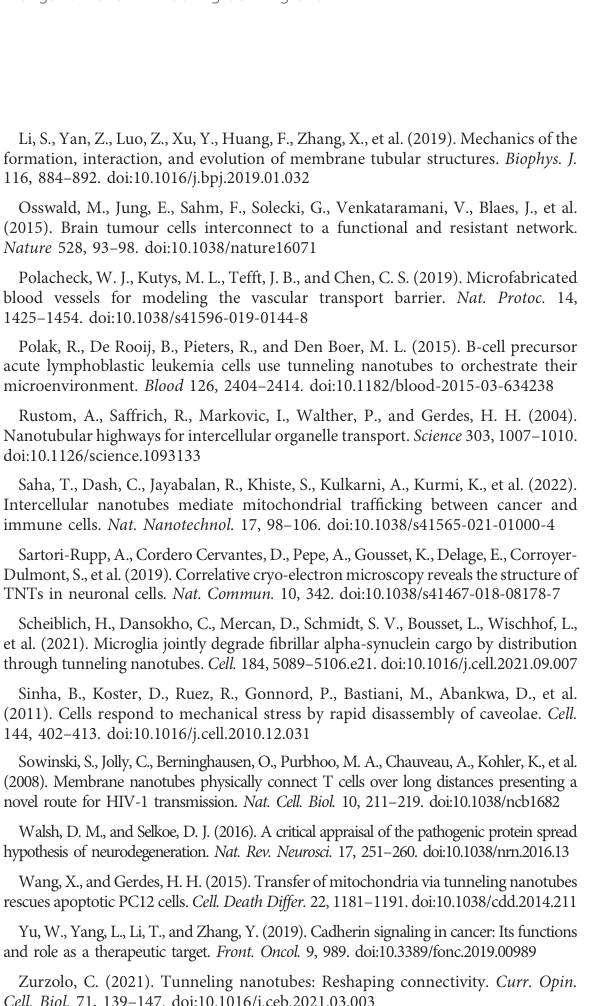
SUPPLEMENTARY FIGURE S2 TNT breaks during cell migration.A TNT (arrow) broke (00:10) when the distance between the TNT-connected cell pair increased due to cell migration. Scale bar, 20 μ m. SUPPLEMENTARY FIGURE S3 Cytoskeletal composition of TNTs and cadherin expression in HEK293 cells. (A) TNTs (arrows) did not contain microtubules (top) and vimentin (bottom). (B) HEK293 cells expressed N-cadherin but not E-cadherin at cellular junctions (arrowheads). Scale bars, 20 μ m. SUPPLEMENTARY FIGURE S4 Effect of different concentrations of drugs on the number of TNTs.Cells cultured in Ibidi chambers were treated with EGTA (10, 50, 100, and 500 μ M), Mbc (1, 10, 100, and 500 μ M), and cytoD (10, 20, 50, and 100 nM) separately for 60 min. The number of TNTs was counted before and after the treatment. SUPPLEMENTARY FIGURE S5 Treatment of cytoD inhibits the F-actin fl ow rate in TNTs.Cells were treated with 20 or 50 nM cytoD for 30 min. The fl ow rate of F-actin in the middle position of TNTs was measured. SUPPLEMENTARY MOVIE S1 Life-imaging of cavin-1-EGFP on a TNT in Figure 2B. SUPPLEMENTARY MOVIE S2 Elongation of a TNT during cell